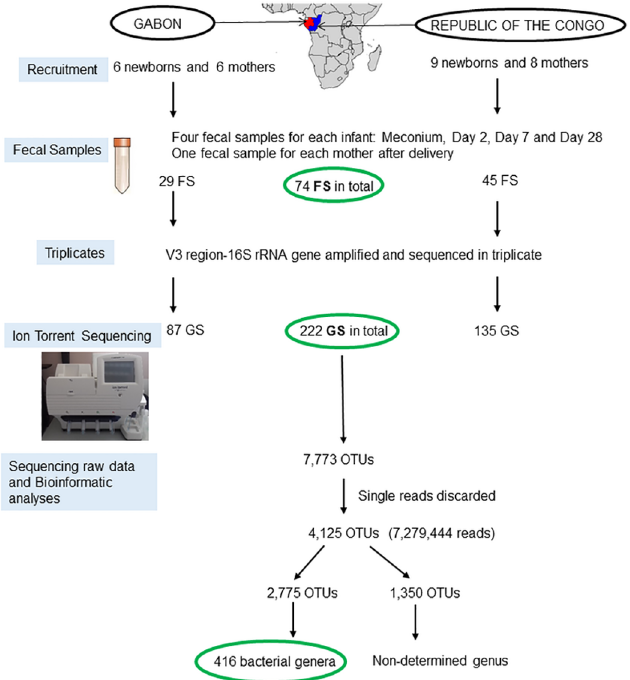
Fig 1. Study location and data acquisition process. OTU: (Operational TaxonomicUnit). African map (source: CIA World Data Bank II;